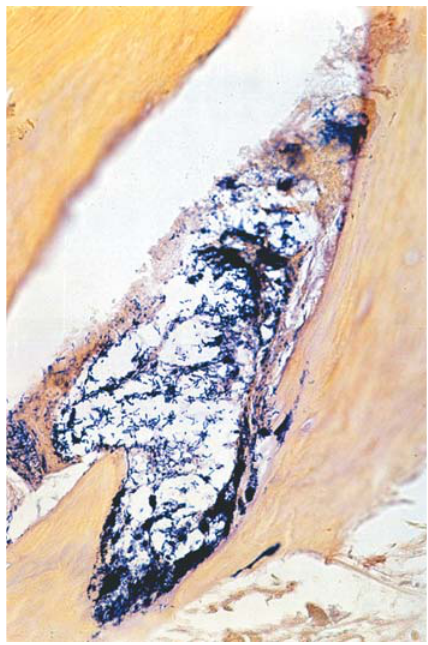
FIGURE 5- Panoramic view of the apical and periapical region. Several microbial morphotypes in the RCS and periapical region, Brown & Brenn -